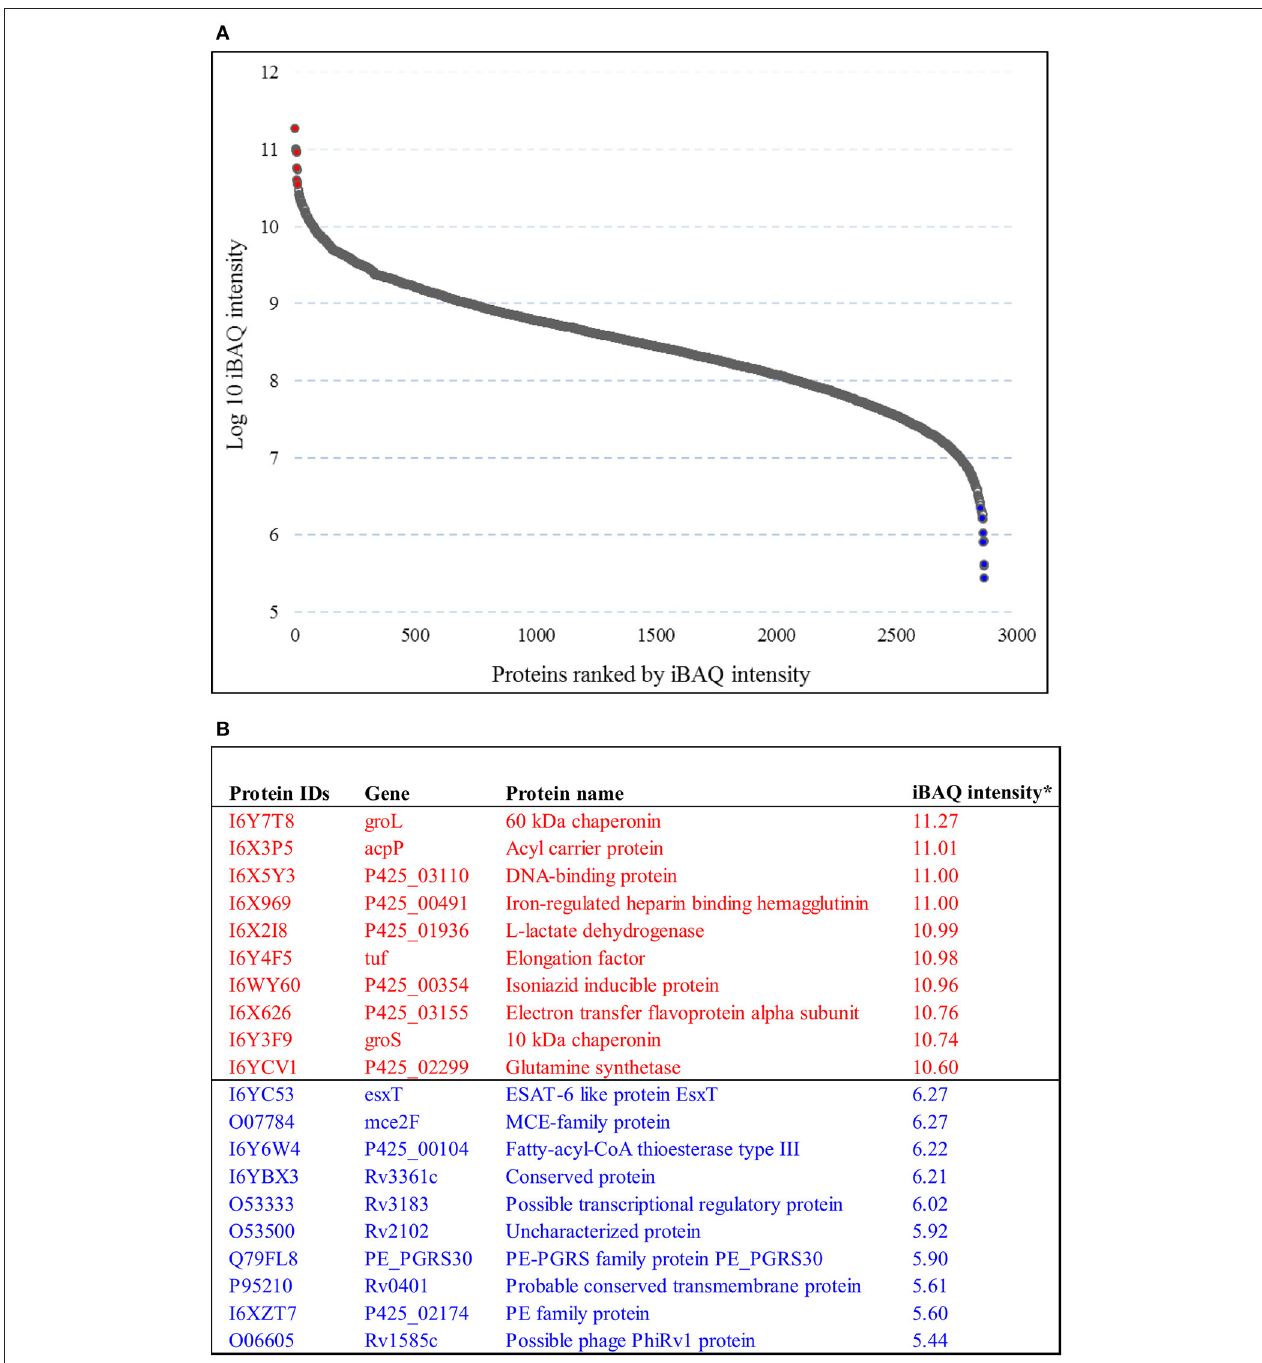
FIGURE 2 | Protein dynamic range estimation. (A) Combined intensity based absolute quantification (iBAQ) values for the 2,825 proteins were plotted with log 10 iBAQ intensity on the y axis, and proteins were ranked by iBAQ intensity on the x axis. The plot shows a dynamic range of 6 orders of magnitude. (B) List of the ten most (colored red) and 10 least (colored blue) abundant proteins based on iBAQ intensity.